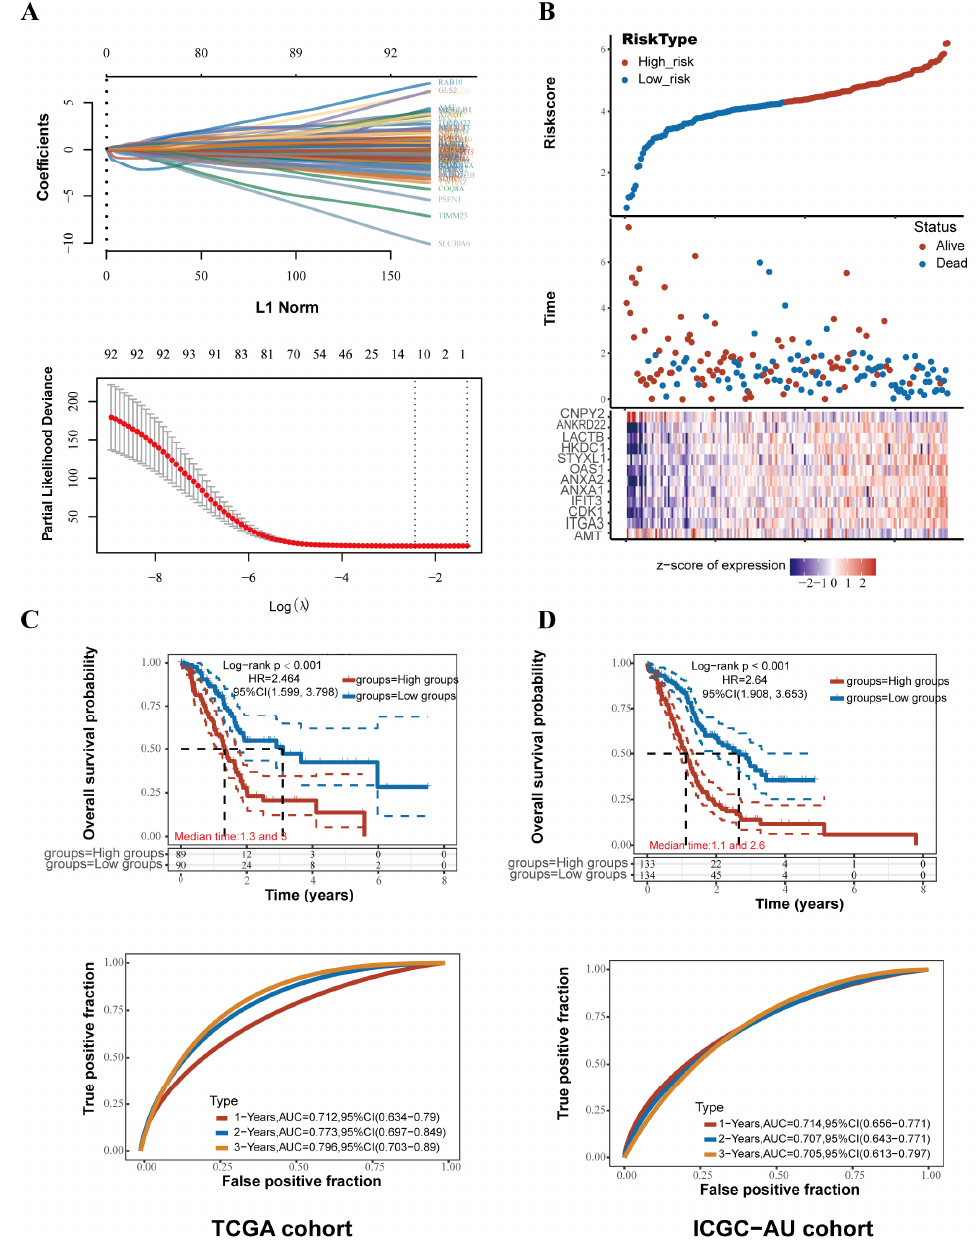
Figure 3. Construction and validation of the nuclear mitochondria-related gene signature. ( A ) LASSO Cox regression analysis determined a total of 12 NMGs as the optimal combination for the NMG signature construction. ( B ) Distribution of the risk score, overall survival, and survival